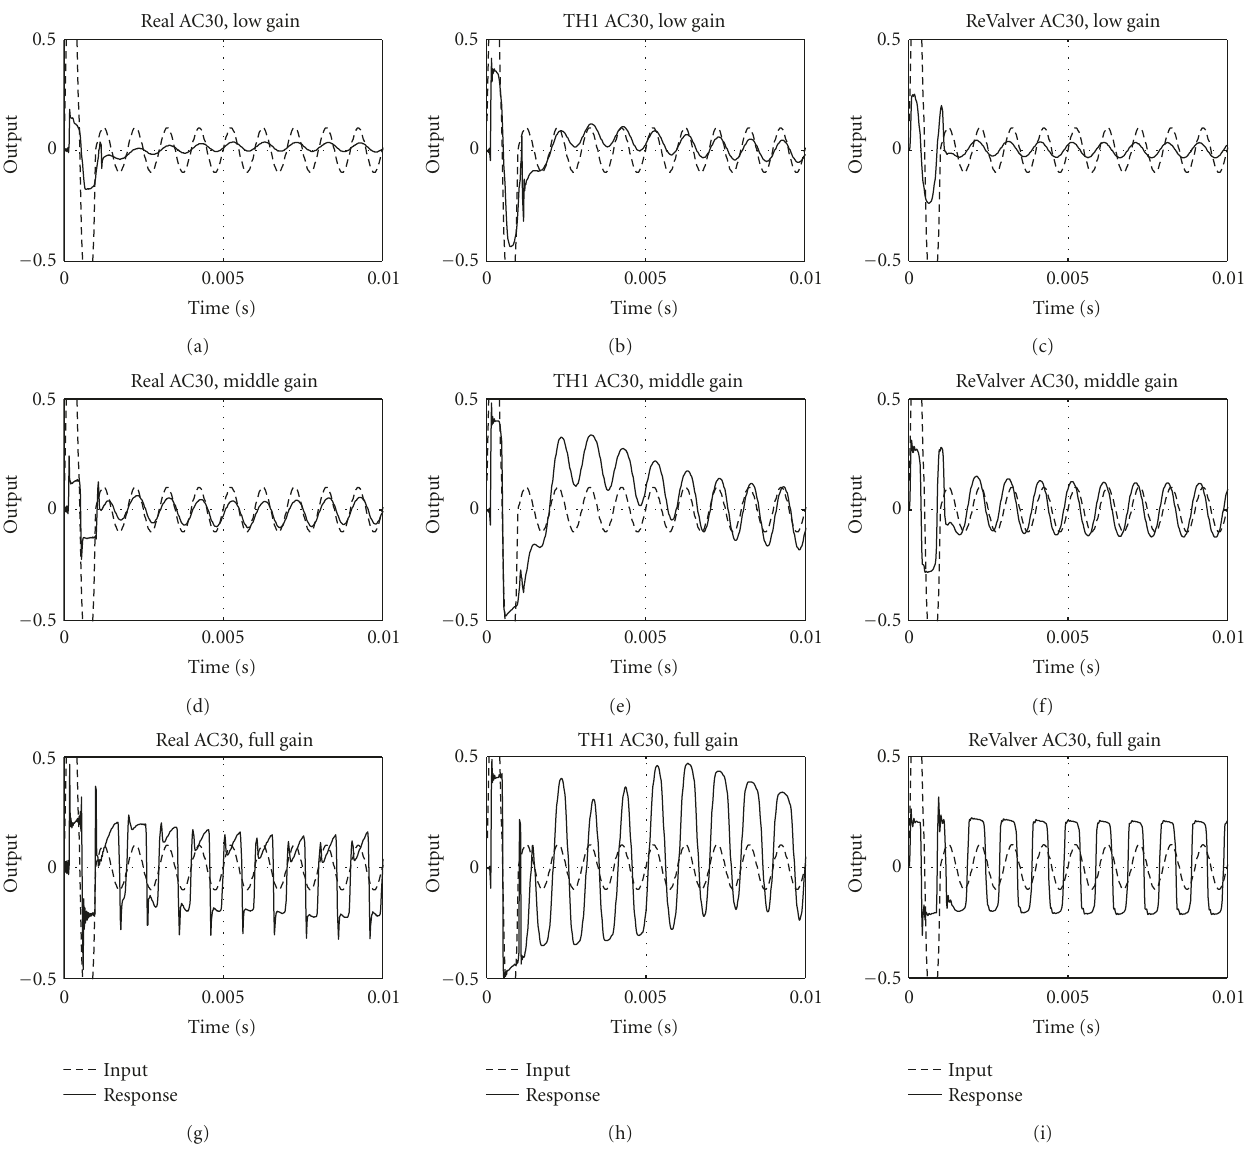
Figure 6: Transient analysis waveforms for the real AC30 (left column), the TH1 AC30 (middle column), and the ReValver AC30 (right column). The input signal is illustrated with a dashed line, while the solid line denotes the measured response. The gain knob was first set to 9 o’clock (top row), then to 12 o’clock (middle row), and finally to full (bottom row).